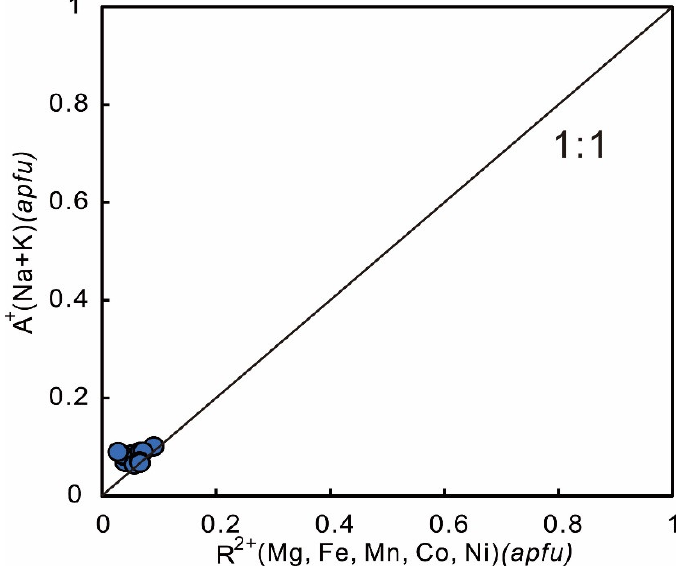
Figure 11. Plots of R 2+ (divalent cations in octahedral site, including Mg, Fe, Mn, Ni) versus A + (monovalent alkali cations in channel, including Na, K).